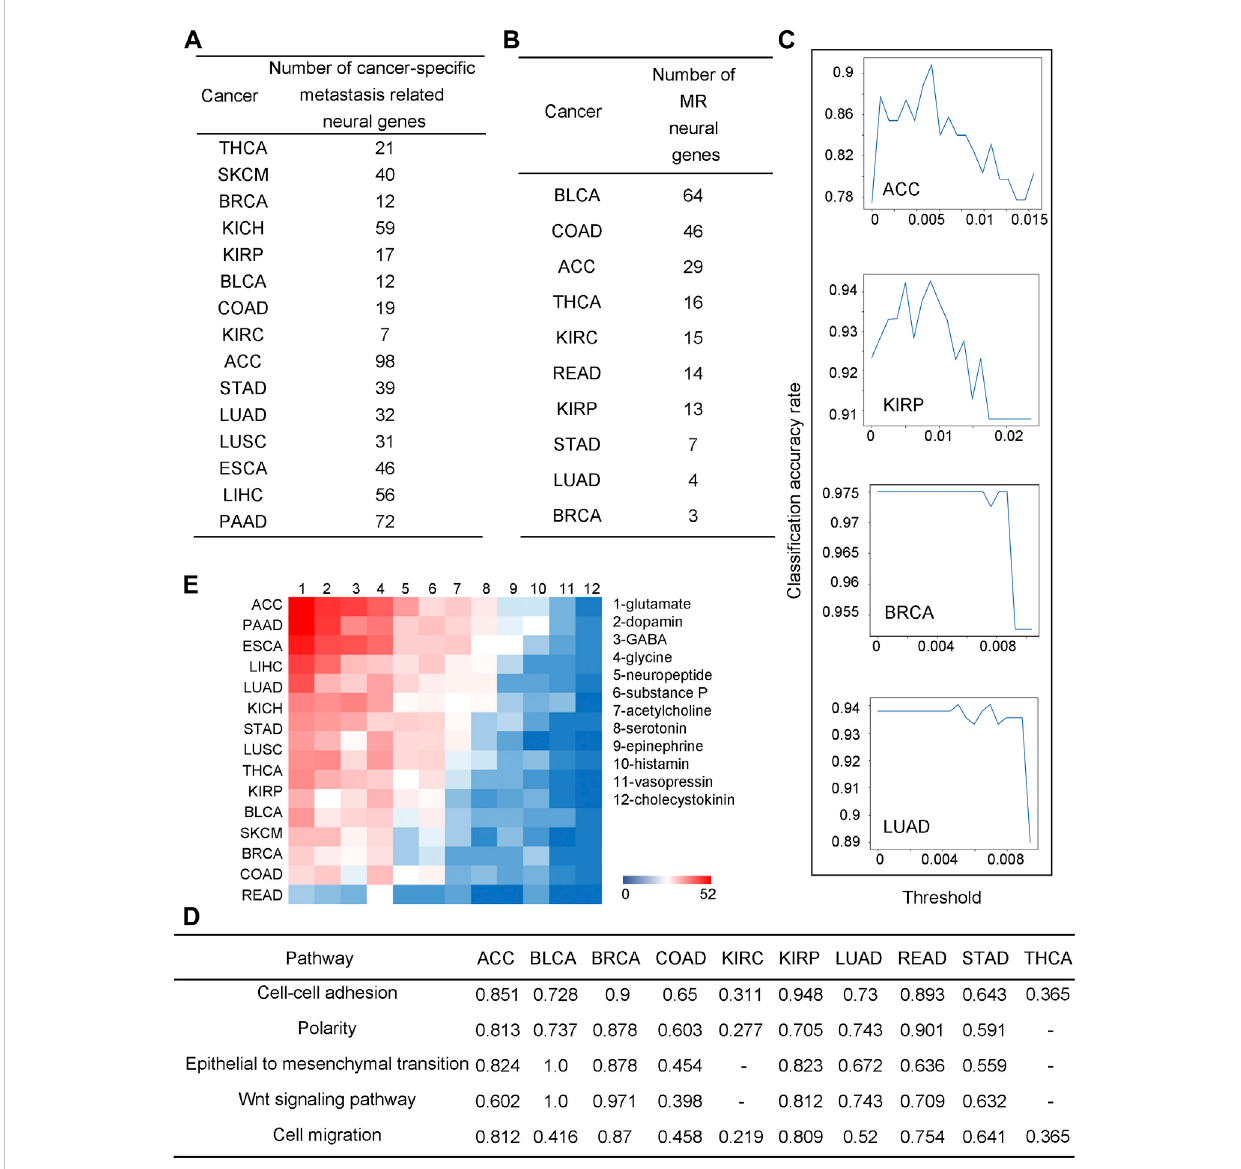
Neural genes are involved in cancer metastasis. (A) The number of neural genes strongly co-expressed with metastatic genes across different cancers. (B) The number of neural genes selected by the random forest-based classi fi cation. (C) Line charts for the classi fi cation performance by the random forest model for ACC, BRCA, KIRP, and LUAD. The x-axis is the threshold for feature selection, where if the value of a feature is lower than the threshold,thefeaturewillbedeleted,andthey-axisisfortheclassi fi cationaccuracy. (D) Correlationcoef fi cientsbetweenselectedneuralgenesand metastatic pathways, “ - ” is for coef fi cients not statistically signi fi cant, i.e., p -value > 0.05. (E) A heatmap for co-expressions between neurotransmitter genes and metastatic